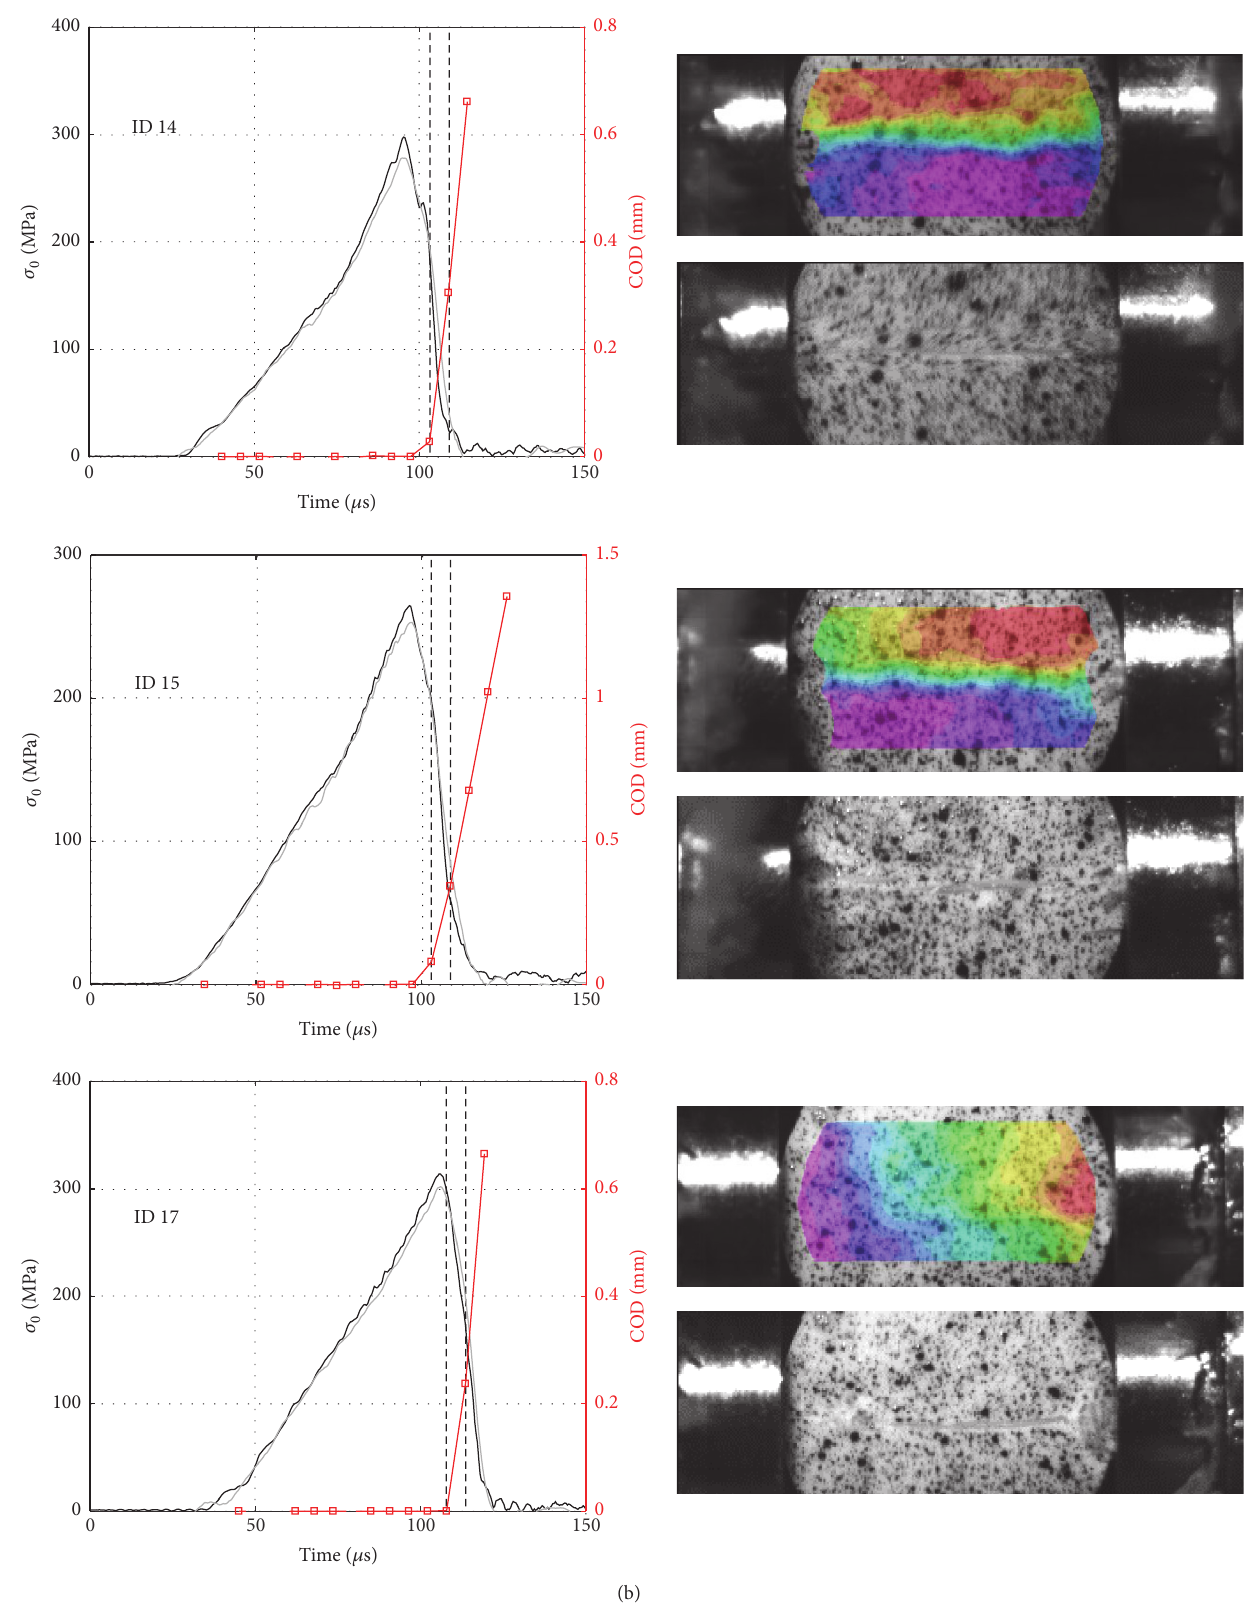
Figure 7: Analysis of the results obtained from dynamic Brazilian test. In the diagrams: equilibrium check by the comparison between input (gray curve) and output (black curve) forces; COD (red curve with markers) calculated by the vertical displacements measured by virtual strain gages placed along the diameter above and under the crack. The images represent two subsequent frames recorded after fracture: DIC analysis for the evaluation of the vertical